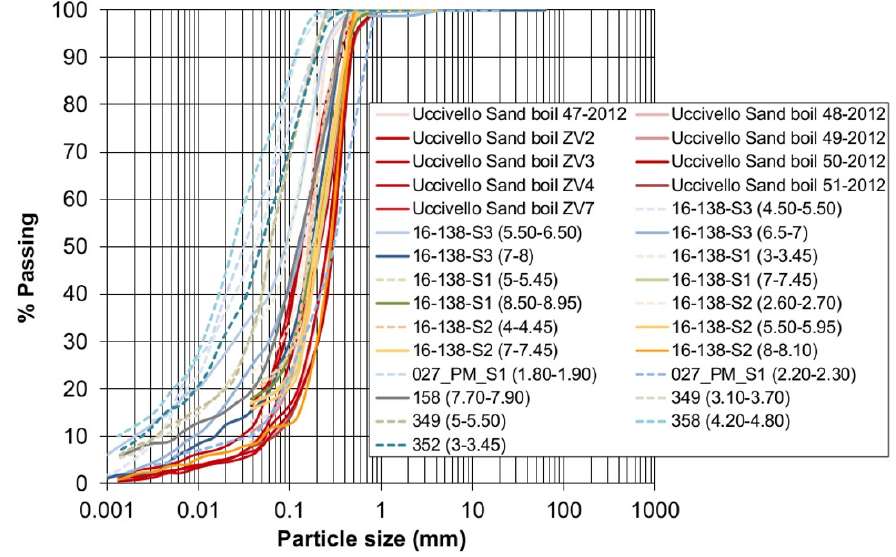
Figure 5. Particle size distribution curves for silty sand (Sl), sand (S), and sandy silt (Ls).